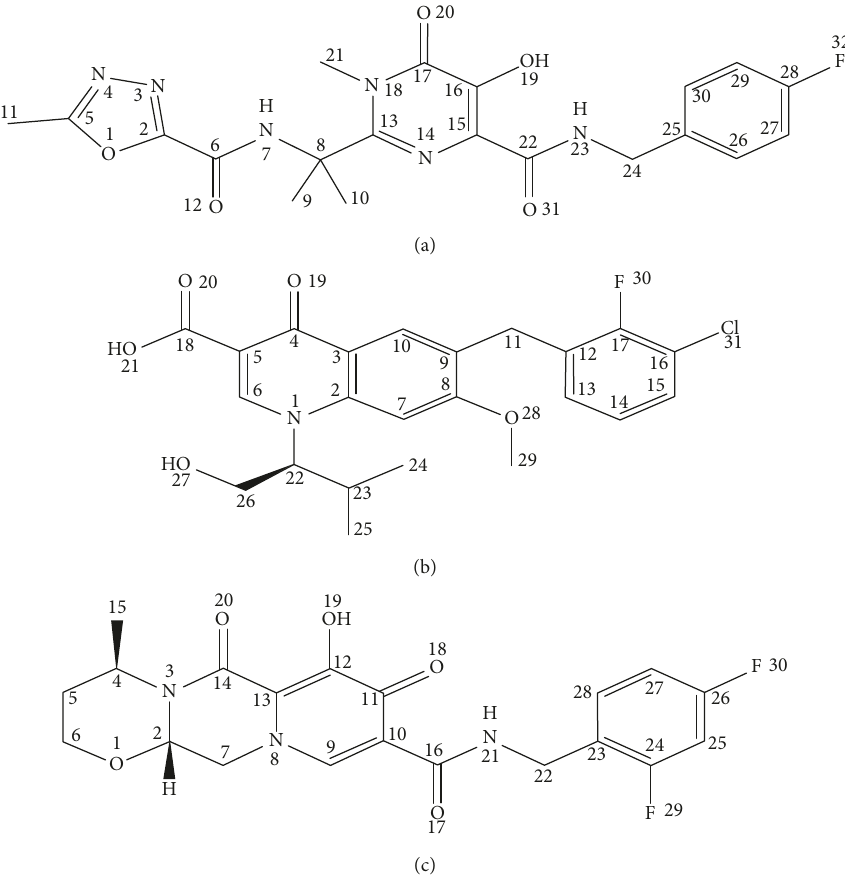
Figure 3: The structures of HIV-1 IN inhibitors. (a) Raltegravir, (b) elvitegravir, and (c) dolutegravir.